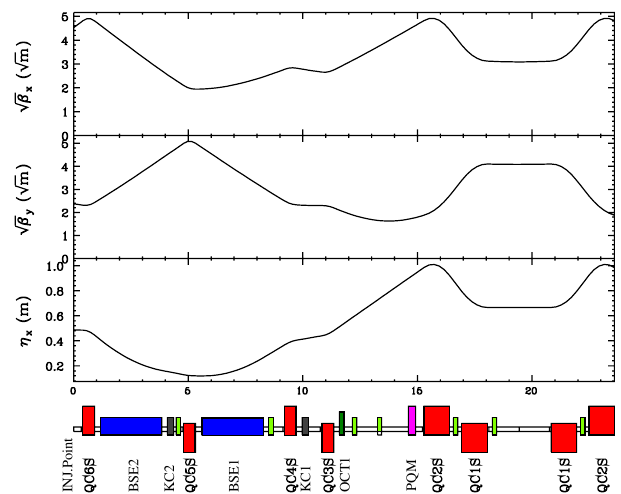
listed in Table I. The lattice consists of four arc sections, four long straight sections of length greater than 20 m, and eight short straight sections of length 5.5 m. The injection point is located at one of the short straight sections in the south region of the ring. The lattice configuration and optical functions around the injection point are shown in Fig. 8. The coordinate at the injection point of the PF-AR is